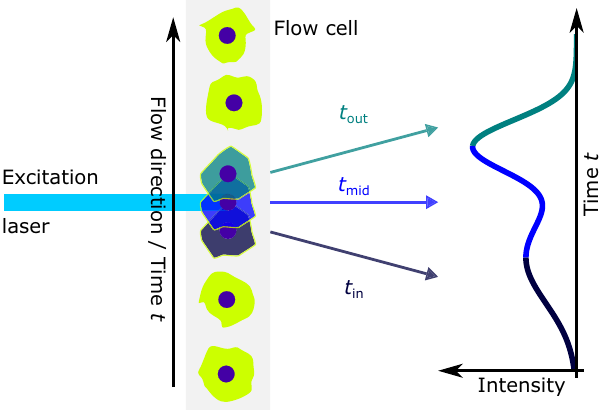
Fig. 7 Illustration of pulse shape generation. A cell moving through the laser beam creates a time-dependent intensity